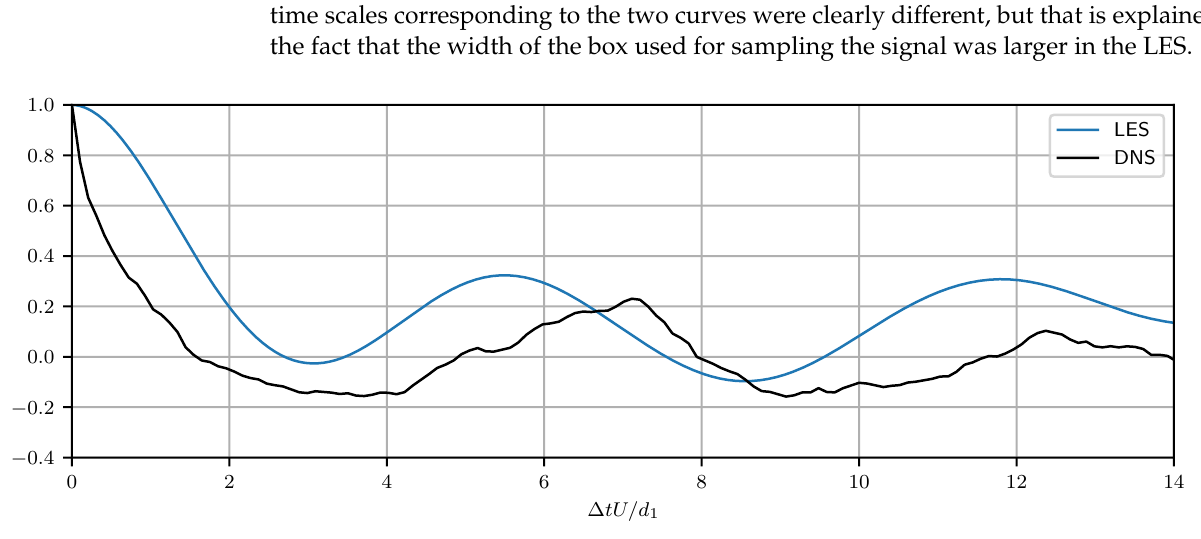
Figure 10. Autocorrelation function of the time signal of the air volume passing through the box x (cid:48) ∈ [ 5.27,6.09 ] , y (cid:48) ∈ [ 0,1.70 ]